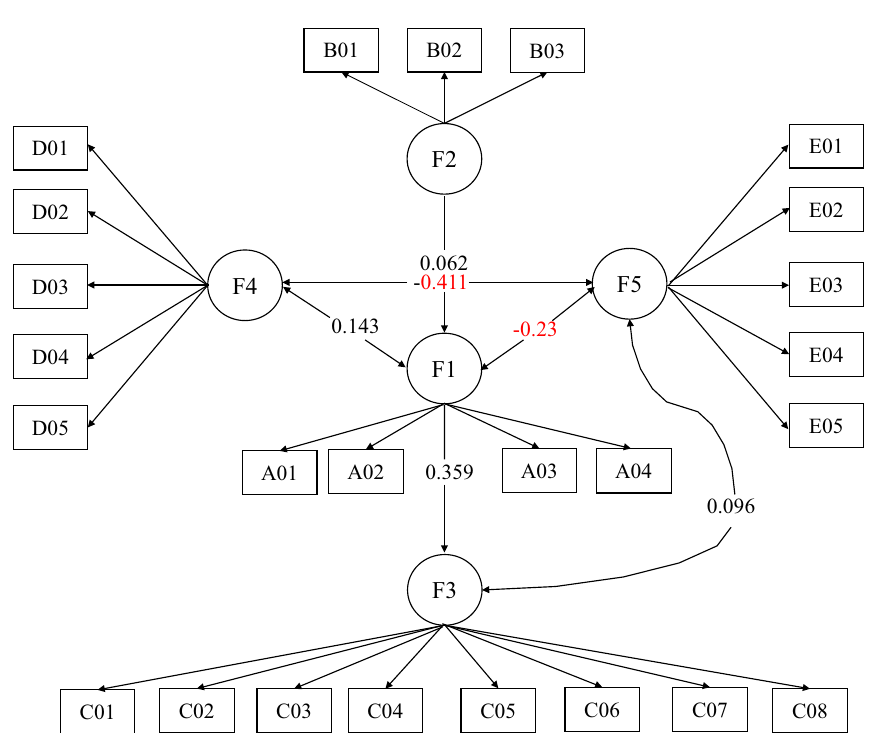
Figure 2. Map of the standardized paths of the structural equation model of the influencing factors of PAID-5 and WHO-5